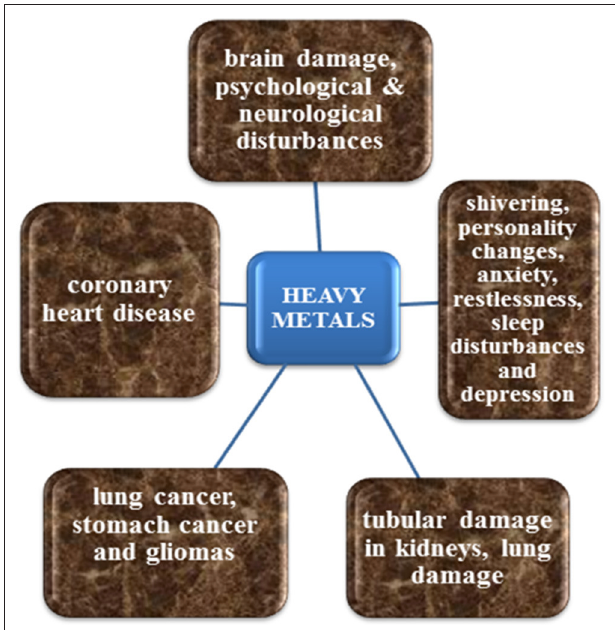
FIGURE 3 | Human health effects of heavy